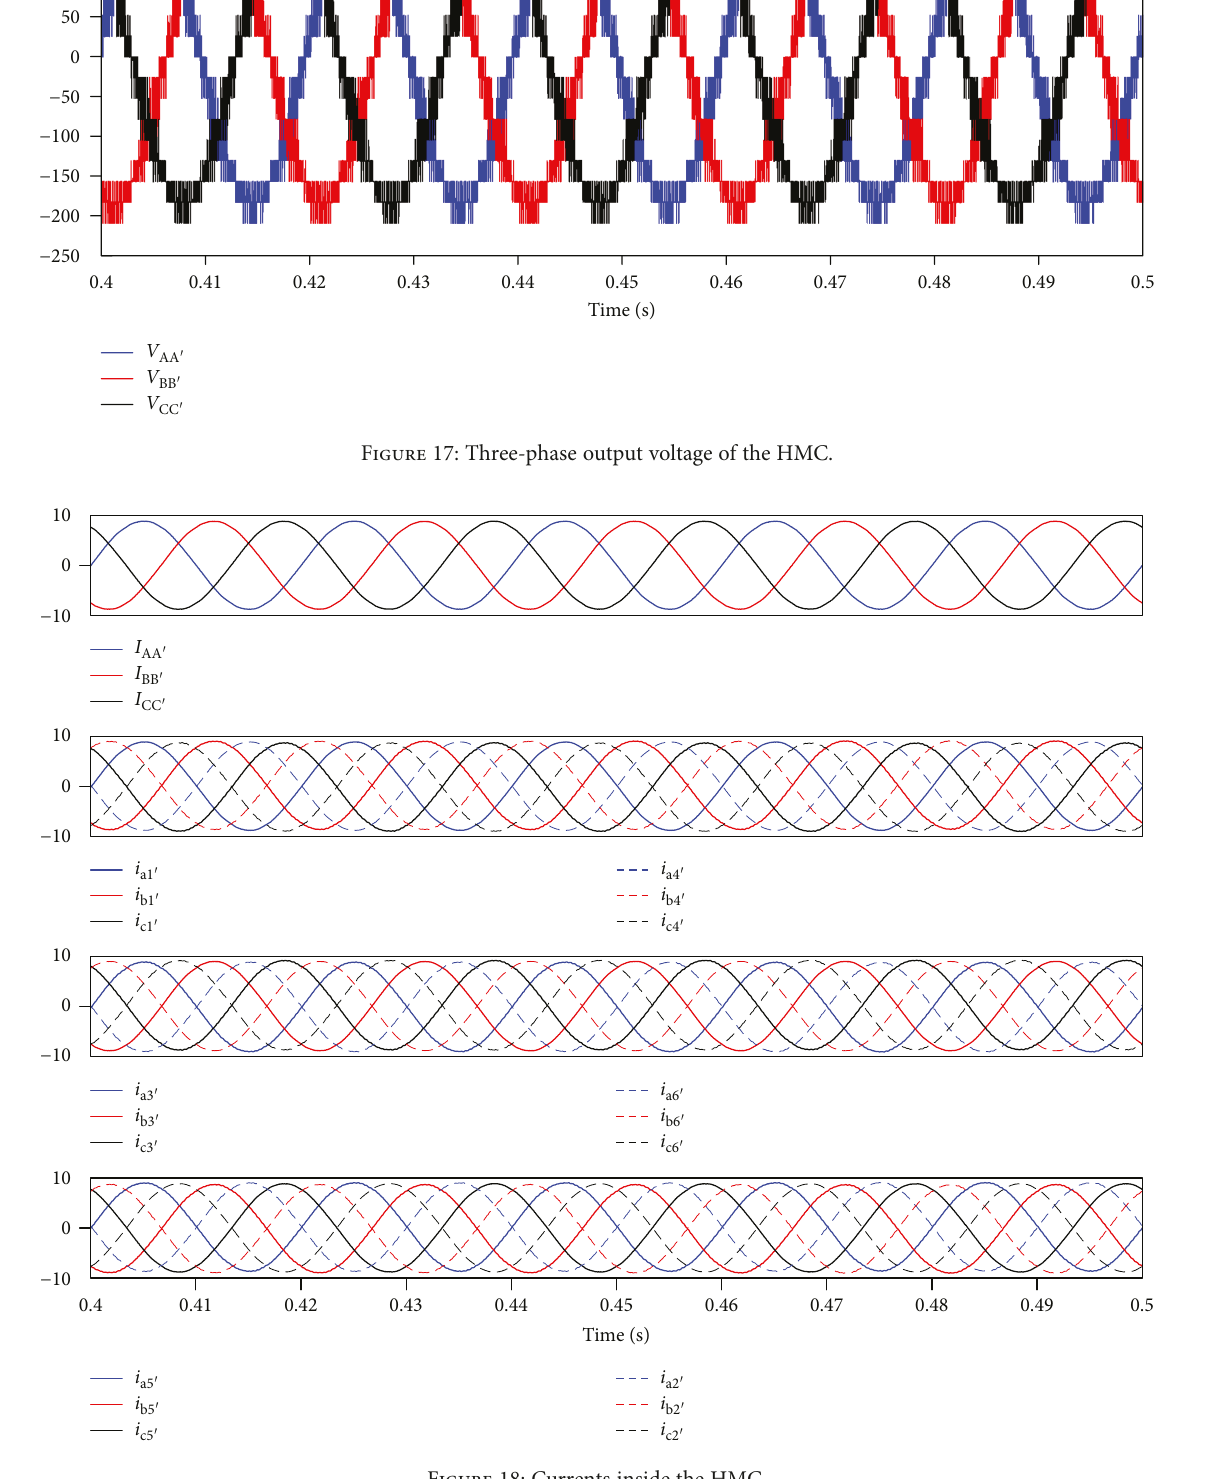
Figure 18: Currents inside the